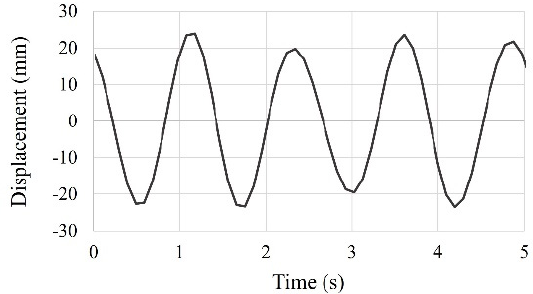
Figure 12. Time history curve of the small-scale model under sinusoidal forced vibration equal to scaled El Centro earthquake.